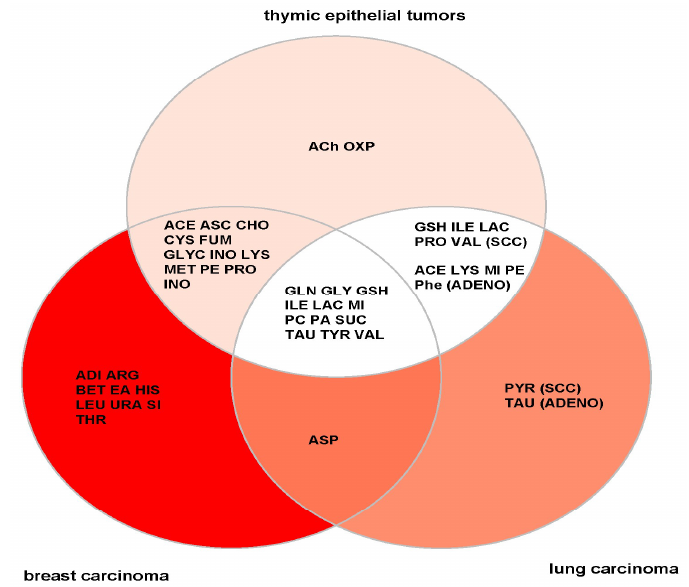
Figure 6. Venn diagram illustrating the metabolite distribution in breast cancer [48], thymic epithelial tumors (TETs) (this study) and lung cancer [55]. Note that most detected metabolites in TETs were also present in lung and breast cancers. Only acetylcholine (ACh) and oxypurinol (OXP) are ‘unique’ metabolites of TETs. The ‘unique’ metabolites of squamous cell (SCC) lung carcinoma and adenocarcinoma (adeno) of the lung were pyruvate (PYR) and taurine (TAU), respectively. In contrast to several non-specific metabolic features detected in TETs, acetylcholine and oxy- purinol are potentially TET-specific metabolites since they were undetectable in breast and lung cancers (Figure 6). The detection of appreciable levels of acetylcholine is intriguing since acetylcho- line receptor subunits are expressed in the tumor cells of thymomas, particularly if associated with Myasthenia gravis (MG) [56]. Accordingly, sufficiently powered, future metabolite profiling anal- yses of myasthenic versus non-myasthenic TETs might open new insights into the enigmatic path- ogenesis of TET-associated MG. Why acetylcholine was detected in TETs but not in breast and lung cancers is unclear. Acetylcholine levels in tissues are regulated by the interplay of synthesis, degra- dation and transport [57]. Therefore, we analyzed TCGA transcriptomic data sets of TETs, breast and lung cancers (CBioPortal, http://www.cbioportal.org/ accessed on 09 March 2022) for the ex- pression of the two key synthesizing enzymes (choline acetyltransferase [CHAT] and carnitine acetyltransferase [CRAT]), the key degrading enzyme (acetylcholine esterase [ACHE]) and several